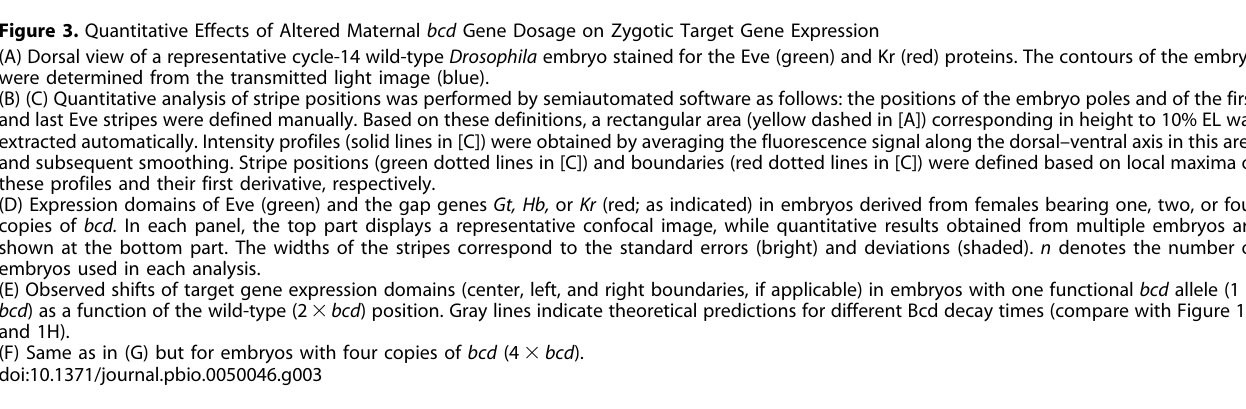
Figure 3. Quantitative Effects of Altered Maternal bcd Gene Dosage on Zygotic Target Gene Expression (A) Dorsal view of a representative cycle-14 wild-type Drosophila embryo stained for the Eve (green) and Kr (red) proteins. The contours of the embryo were determined from the transmitted light image (blue). (B) (C) Quantitative analysis of stripe positions was performed by semiautomated software as follows: the positions of the embryo poles and of the first and last Eve stripes were defined manually. Based on these definitions, a rectangular area (yellow dashed in [A]) corresponding in height to 10% EL was extracted automatically. Intensity profiles (solid lines in [C]) were obtained by averaging the fluorescence signal along the dorsal–ventral axis in this area and subsequent smoothing. Stripe positions (green dotted lines in [C]) and boundaries (red dotted lines in [C]) were defined based on local maxima of these profiles and their first derivative, respectively. (D) Expression domains of Eve (green) and the gap genes Gt, Hb, or Kr (red; as indicated) in embryos derived from females bearing one, two, or four copies of bcd. In each panel, the top part displays a representative confocal image, while quantitative results obtained from multiple embryos are shown at the bottom part. The widths of the stripes correspond to the standard errors (bright) and deviations (shaded). n denotes the number of embryos used in each analysis. (E) Observed shifts of target gene expression domains (center, left, and right boundaries, if applicable) in embryos with one functional bcd allele (1 3 bcd ) as a function of the wild-type (2 3 bcd ) position. Gray lines indicate theoretical predictions for different Bcd decay times (compare with Figure 1G and 1H). (F) Same as in (G) but for embryos with four copies of bcd (4 3 bcd ).